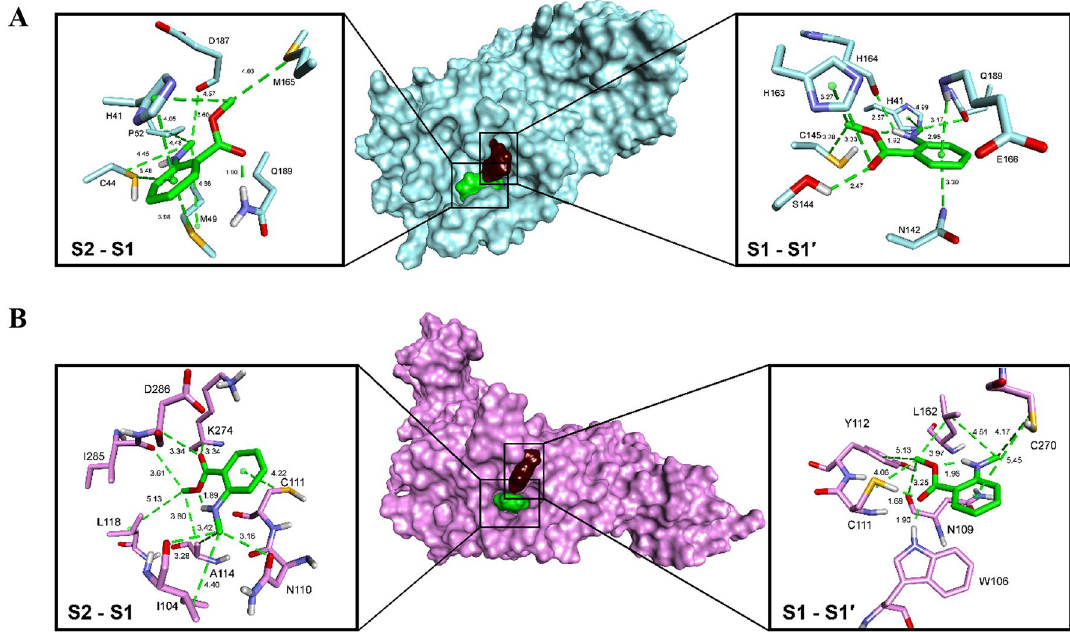
Figure 1. The interactions of dimethyl anthranilate in the active centers of SARS-CoV-2 M pro ( A ) and SARS- CoV-2 PL pro ( B ). The binding for each enzyme is shown for the S1-S1 ′ and S2-S1 pockets. The surface of the enzymes is colored light blue (M pro ) or light pink (PL pro ). The surface of methyl N -methylanthranilate is colored dark brown for the S1-S1 ′ pockets and green for the S2-S1 pockets. The ligands and the side chains of the amino acids are shown as sticks, and the bond order is not